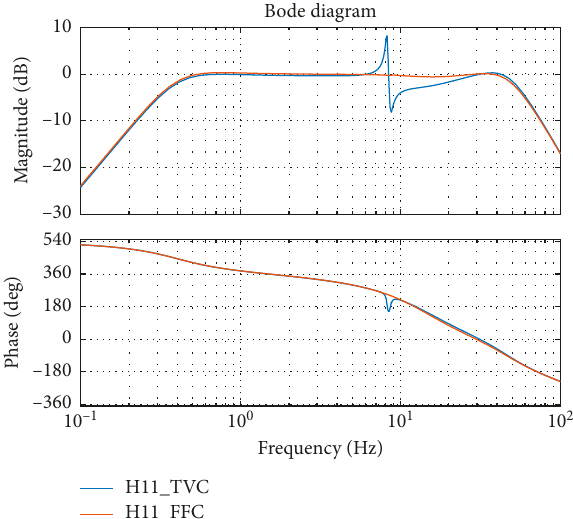
Figure 13: Acceleration time history of the dual shaking tables 11 . without/with specimen under TVC.